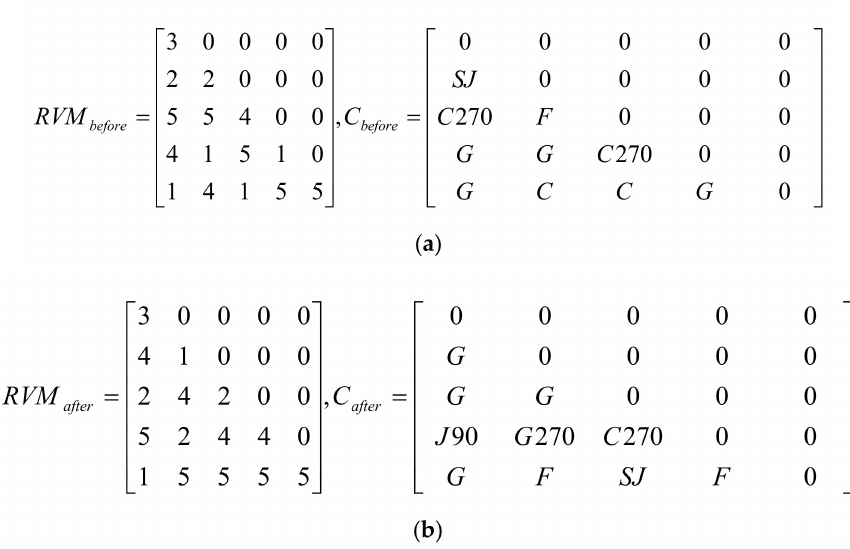
Figure 5. Structures of RVM, along with the best-fit copula family matrix, where C—Clayton copula, F—Frank copula, G—Gaussian copula, J90—rotated Joe copula (90 degrees), C270—rotated Clayton copula (270 degrees), G270—rotated Gumbel copula (270 degrees), and SJ—rotated Joe copula